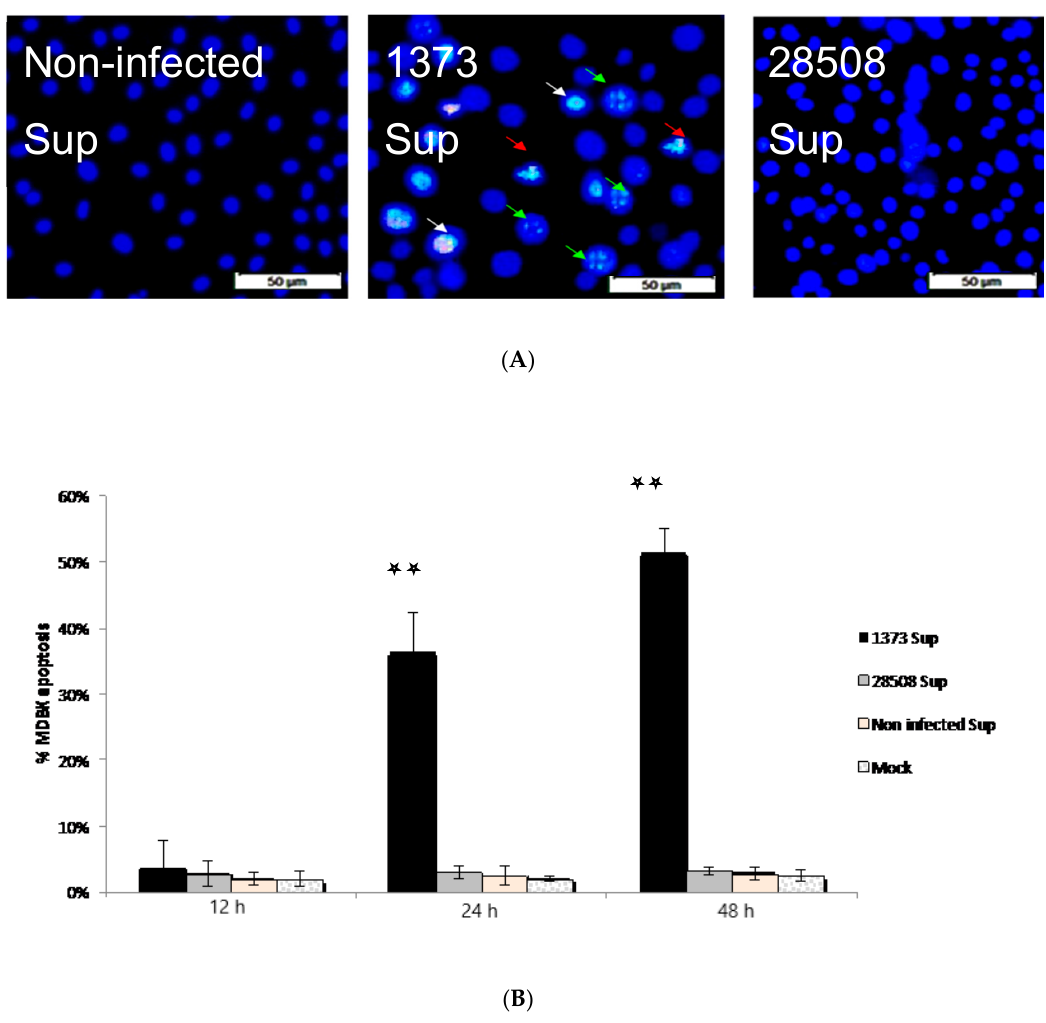
Figure 6. The indirect (infected MDM 24 h supernatant) effect of different BVDV strains on MDBK apoptosis. ( A ) Chromatin condensation by 1373 strain in contrast to 28508-5 and non-infected supernatant. ( B) The % of MDBK apoptosis in response to different supernatants. 1373 Sup: BVDV 1373-infected macrophage supernatant, 28508-5 Sup: BVDV 28508-5-infected macrophage